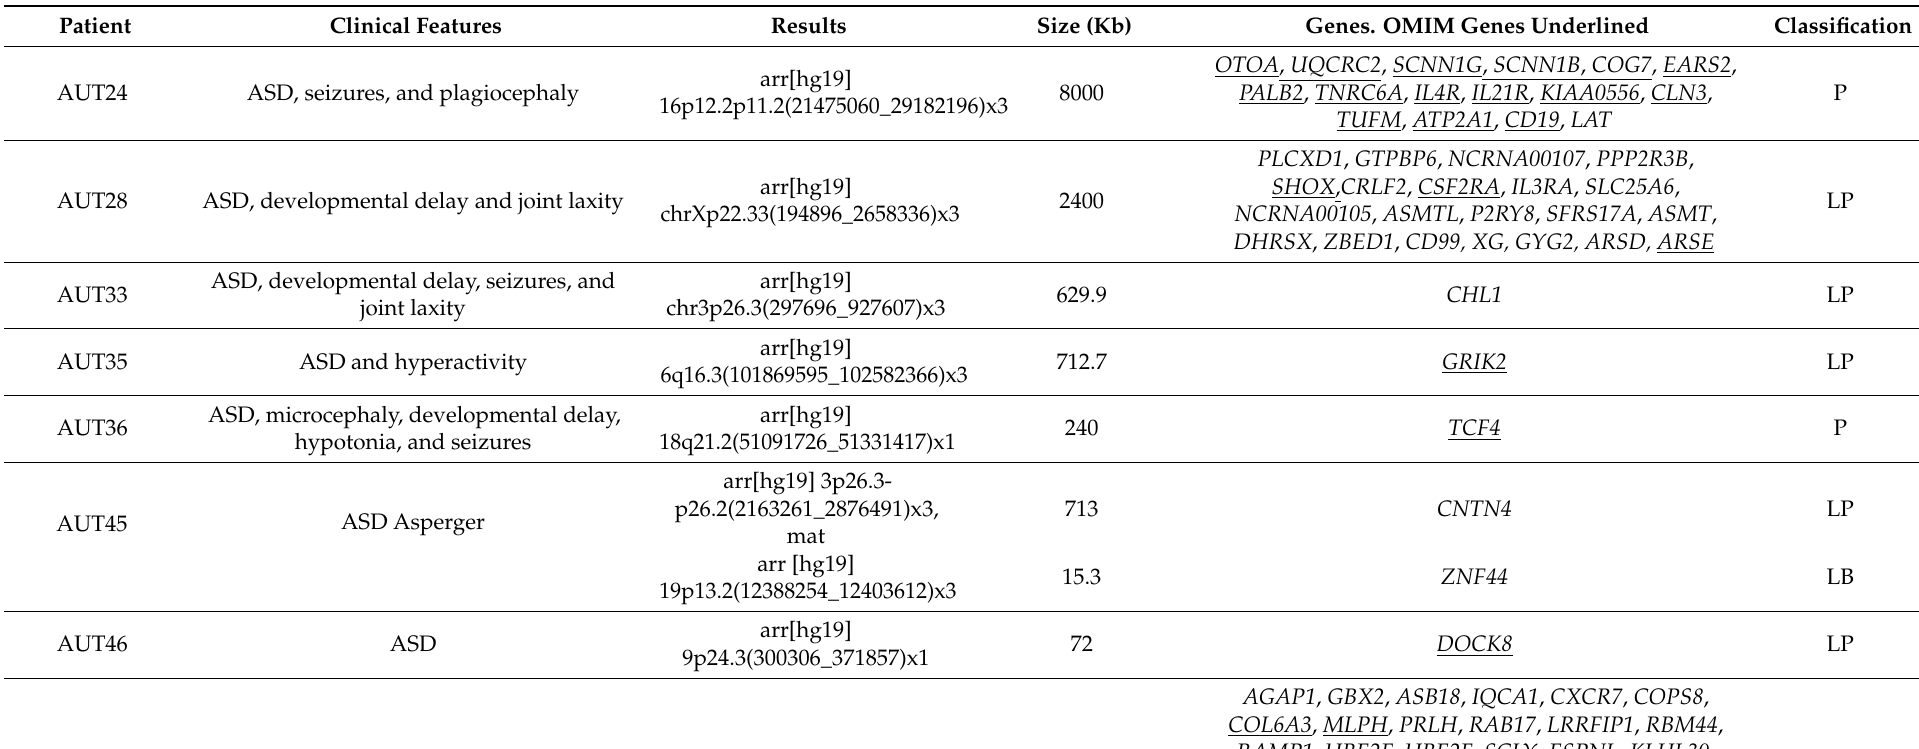
Table 1. Pathogenic and likely pathogenic variants found in the cohort of primary ASD